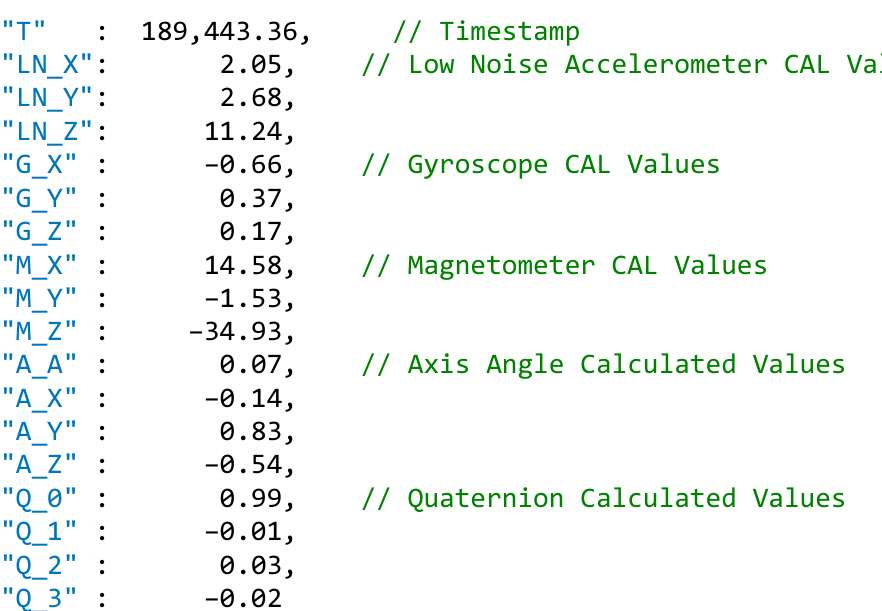
Figure 4. JavaScript Object Notation (JSON) formatted data for a single reading. The quaternions are used to calculate the roll, pitch and yaw to be reflected in the Unity 3D model. The calculations for these are conducted with the method shown in the code sample in Figure 5 and are based on standard math formulas for this Table 1. Sample reading of data returned from the inertial measurement unit (IMU). Accelerometer values are in metres per second squared (m/s 2 ), the gyroscope returns degrees per second (°/s) and the magnetometer provides flux (cgs) values.